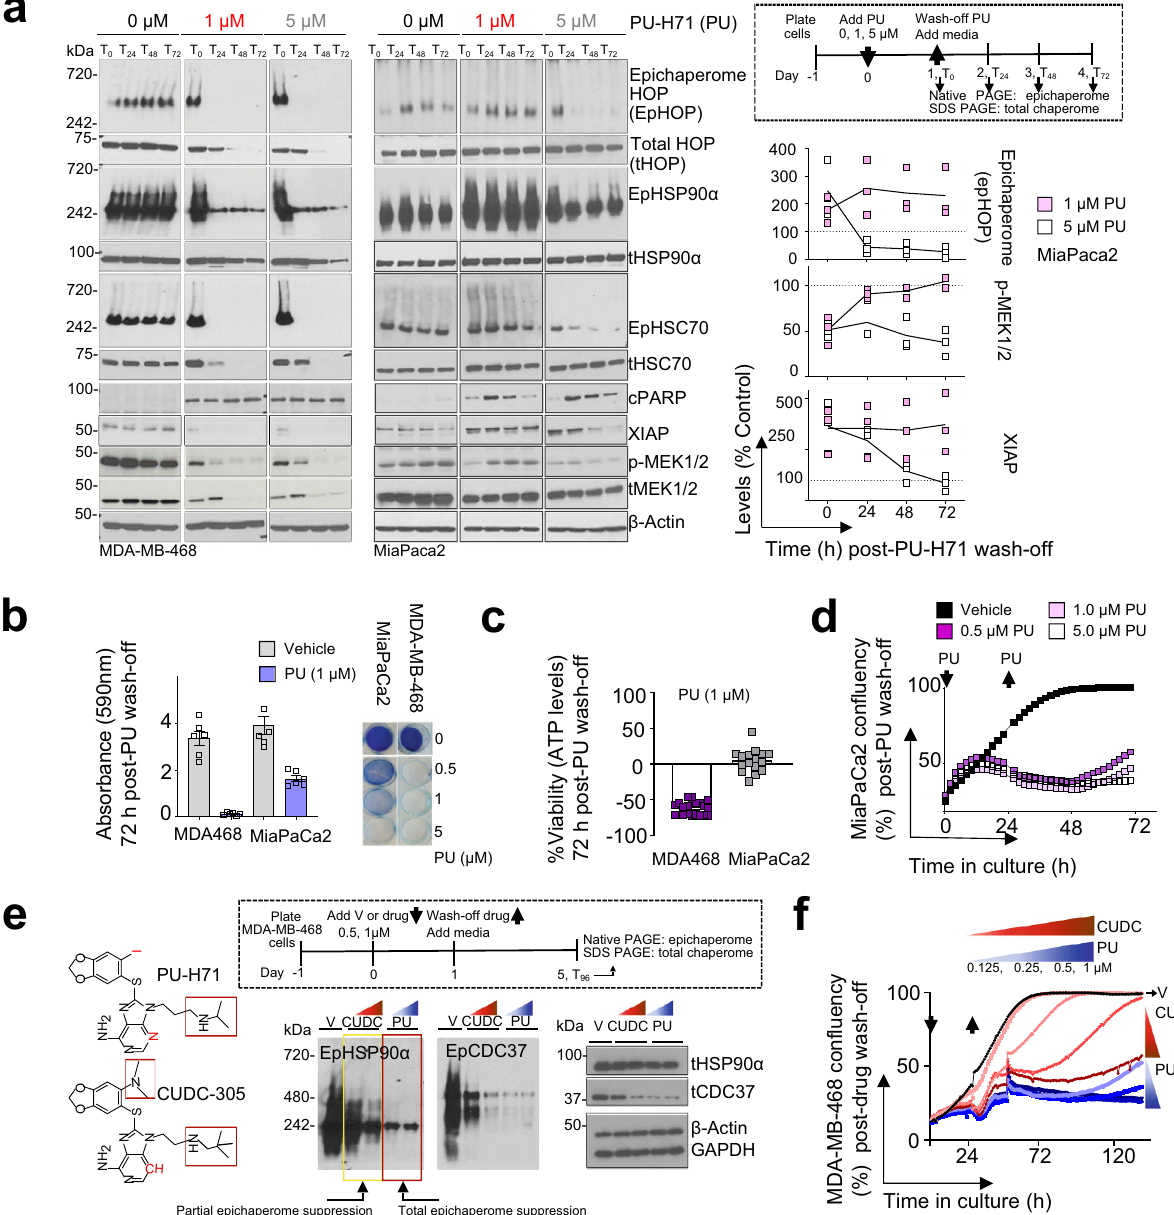
Fig. 2 Unoccupied epichaperome capacity enables recovery. a Dynamics of epichaperome and total chaperome pools at 0 to 72h following treatment of cells for 24h with PU-H71 (0, 1, 5 µ M). T 0 to T 72 , 0h to 72h post-inhibitor wash-off from the cell culture. Native-PAGE, epichaperome levels; SDS-PAGE, total chaperome levels; p-MEK, read-out for MAPK signalling pathway activity; XIAP and cleaved PARP, cell survival and death markers, respectively; β -actin, protein loading control. Graph, individual datapoints of 3 experimental repeats for MiaPaCa2. b Viability of cells at 72h post-PU-H71 (PU) or -vehicle removal. Cells were treated for 24h with PU or vehicle prior to wash-off and cytotoxicity evaluation. Error bars represent SEM, n = 6 biological replicates. Representative crystal violet stained cells are also shown. c Same as in ( b ) for cell viability assessed by an ATP-based assay ( n = 16 biological replicates from 3 individual experiments). Negative values represent a decrease in cell numbers compared to the initial cell population. Error bars represent SEM. d Cell con fl uency monitored by live-cell microscopy (IncuCyte) over the interval 0 to 72h of cells treated as in ( a ). Each curve represents the mean of 3 wells, and the data is representative of 3 independent experiments. e Epichaperome and total chaperome pools at 96h following treatment of cells for 24h with Vehicle (V), PU-H71 (0.5, 1 µ M) or CUDC- 305 (0.5, 1 µ M). T 96 , 96h post-inhibitor wash-off from the cell culture. β -actin and GAPDH, protein loading controls. The chemical structure of PU-H71 and CUDC- 305 is also shown. Red box and/or symbol indicate structural differences. The data is representative of 3 independent experiments. f Cell con fl uency monitored by live-cell microscopy (IncuCyte) over the interval 0 to 160h of cells treated as in ( e ) with the indicated concentrations of inhibitors. Each curve represents the mean of 3 wells, and the data is representative of 3 independent experiments.